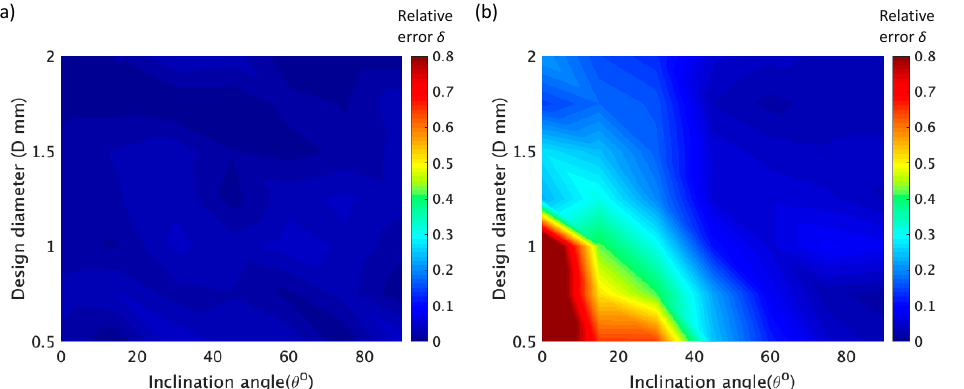
Figure 8. ( a ) Coupled influence of design diameter D and inclination angle θ on relative error δ of the horizontal dimension d1 of the rod unit. ( b ) Coupled influence of D and θ on δ of the longitudinal dimension d2 of the rod unit; d1 and d2 are indicated in Figure 6.